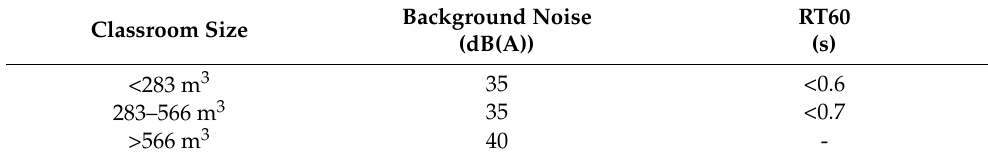
Table 1. Acoustic performance standard for classrooms in the United States (unoccupied).